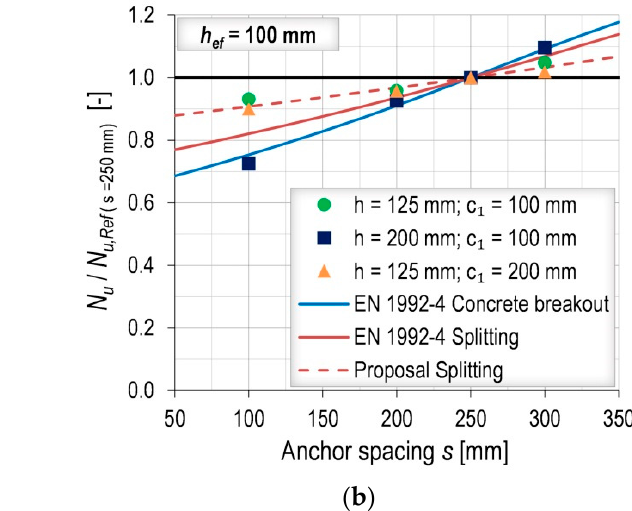
( b ) Figure 7. Influence of edge distance: ( a ) numerical results compared to the current code provisions; ( b ) numerical results for different embedment depths and small h/hef ratios described by a linear function. 5.3. Influence of Anchor Spacing Similar to the influence of edge distance, the numerical results for thin members showed that the characteristic anchor spacing s cr,sp should be larger than the current value of EN 1992-4 which is currently defined as the double of the characteristic edge distance ( s cr,sp = 2 c cr,sp ). As shown in Figure 8a for the member thickness h = 75 mm, the influence of anchor spacing was not relevant for s/c 1 ratios greater than 12, i.e., the results for s = 12 h ef and s = 14h ef are almost at the same level. Moreover, the results obtained for member thick- ness h = 125 mm in Figure 8b (green and orange data points) showed that the curve rep- resenting the influence of the anchor spacing on splitting, according to EN 1992-4, should have a smaller inclination. Knowing that the minimum value of the factor Ψ ch,s,N is 0.5 for a theoretical anchor spacing equal to zero, such an inclination can be achieved only by increasing the characteristic anchor spacing. Therefore, it is proposed to increase the char-